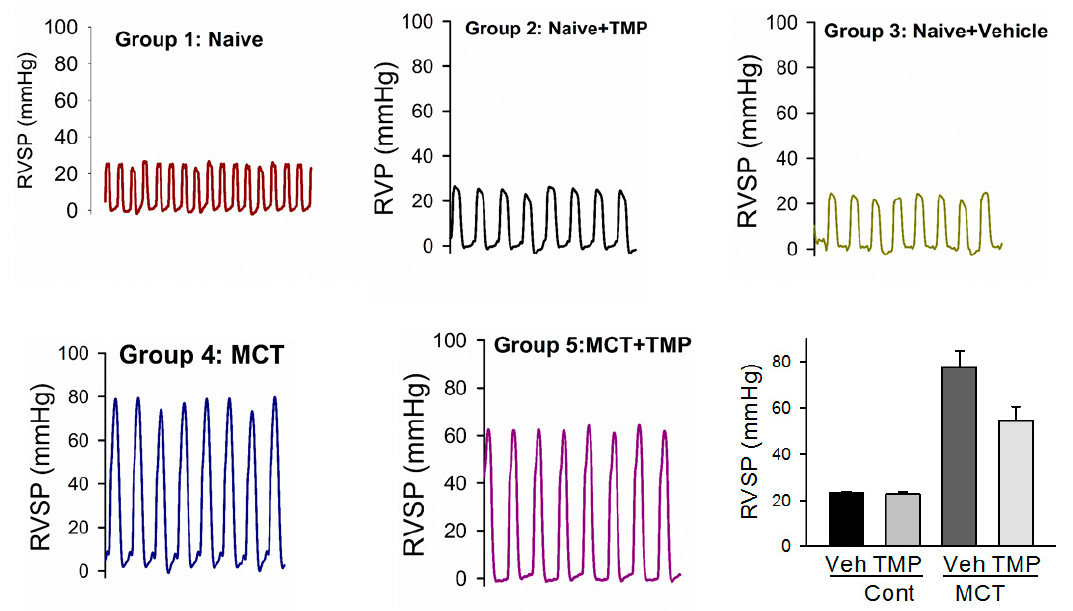
Figure 11. Representative in vivo right ventricle systolic pressure (RVSP) measurements of different rat groups from Microsprayer ® Aerosolizer (liquid aerosol) study.